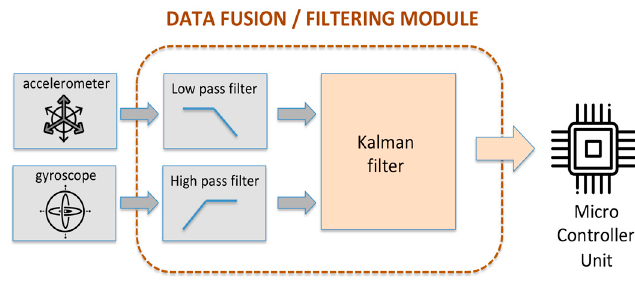
Figure 10. Accelerometer and gyroscope data filtering.